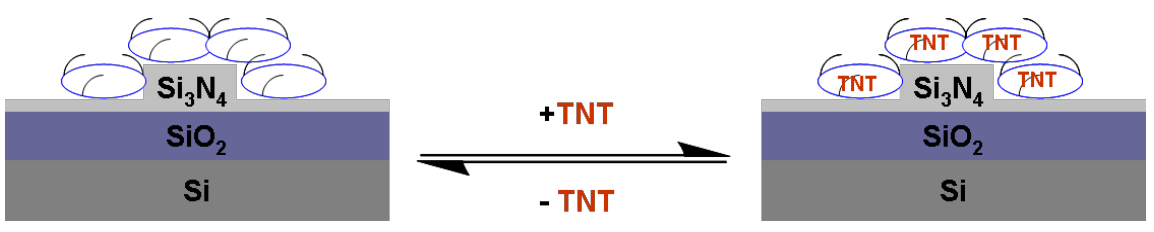
Figure 2. Schematic ridge structure of the microring resonator and reversible intercalation of TNT into schematically drawn